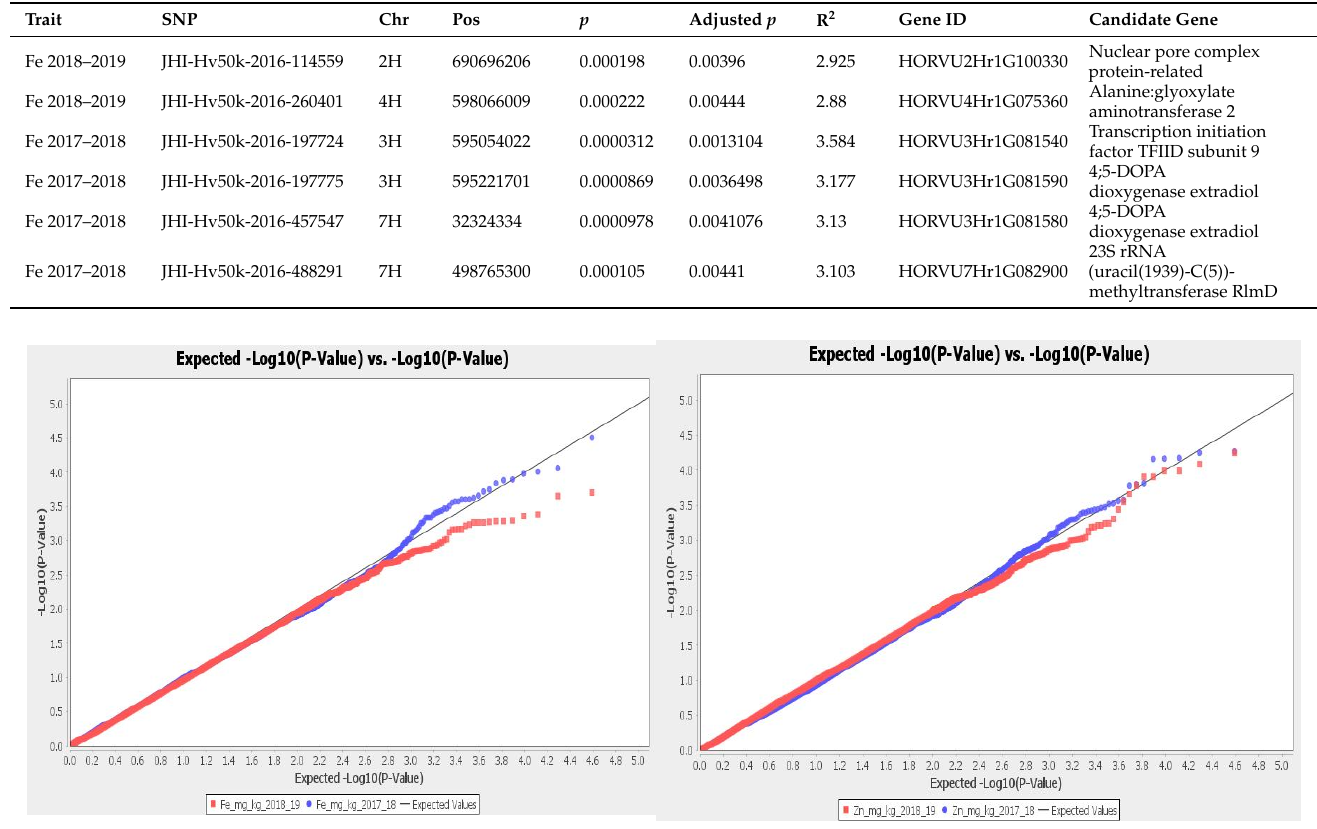
Table 3. Annotation of significant SNPs associated with Fe using BarleyVarDB and Barleymap database; for a complete list, see Supplementary Table S2.